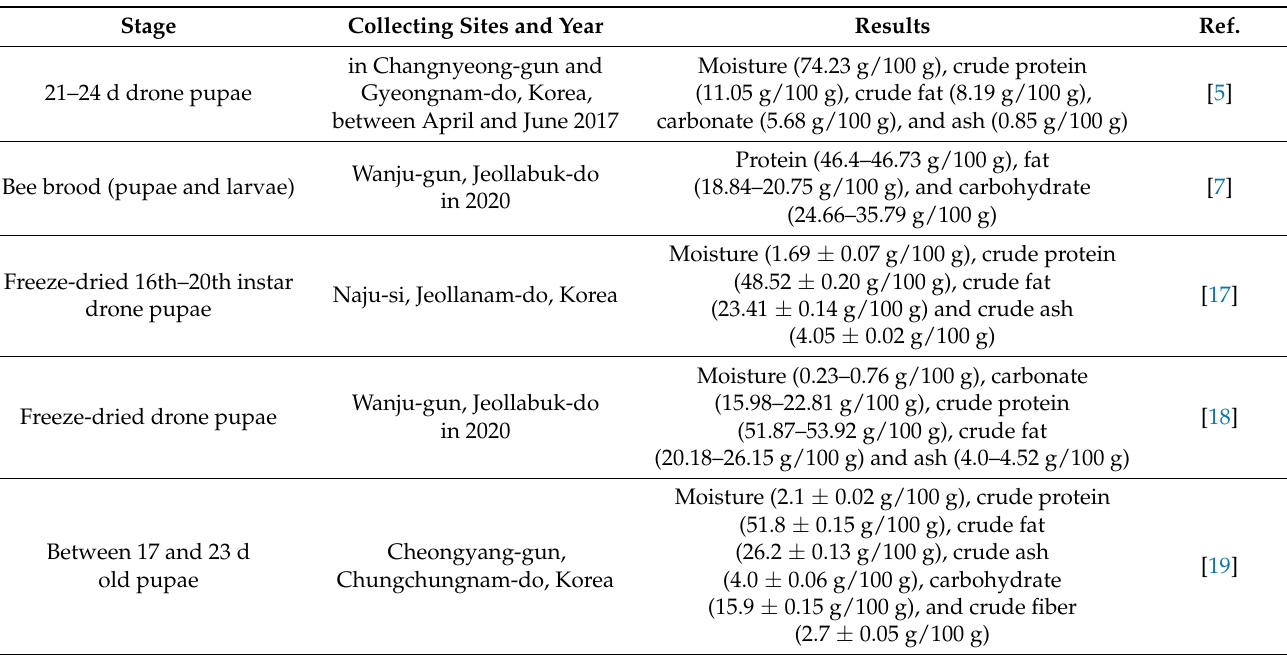
Table 1. Nutritional composition of honeybee ( Apis mellifera L.) drone